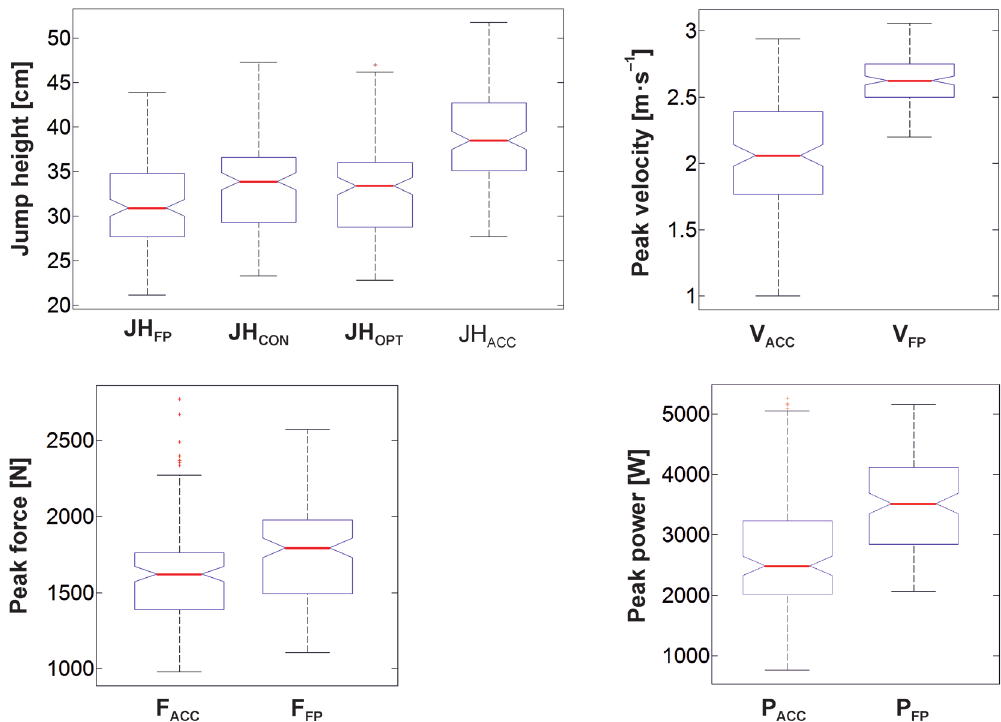
Figure 3. Boxplot of explosive strength indicators. Jump height from force plate flight time ), optic timing system (JH ), accelerometer (JH ), and impulse from the force plate (JH FP OPT ACC (JH ), peak velocity from accelerometer (V ) and force plate (V ), peak force from acceler- CON ACC FP ometer (F ) and force plate (F ), peak power from accelerometer (P ) and force plate (P ). ACC FP ACC FP ) and 75th (Q ) On each box, the central line is the median, the edges of the box are the 25th (Q 1 3 percentiles, the whiskers extend to the most extreme data points not considered as outliers with- – 1.5(Q – Q ) to Q + 1.5(Q – Q ), and outliers are plotted individually. in the range from Q 1 3 1 3 3 1